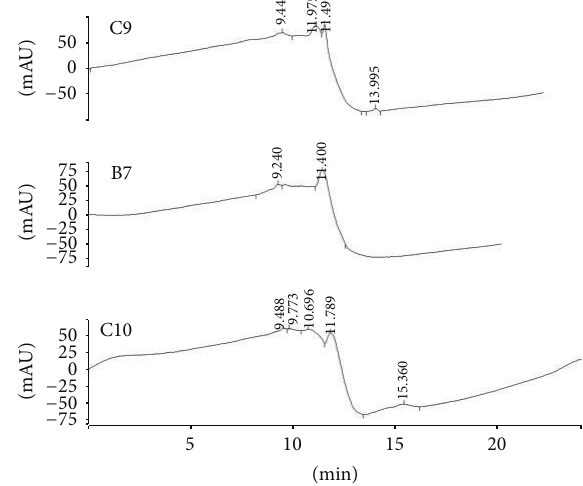
Figure 4: High and low molecular weight compounds of function- alized polyurethane foam.